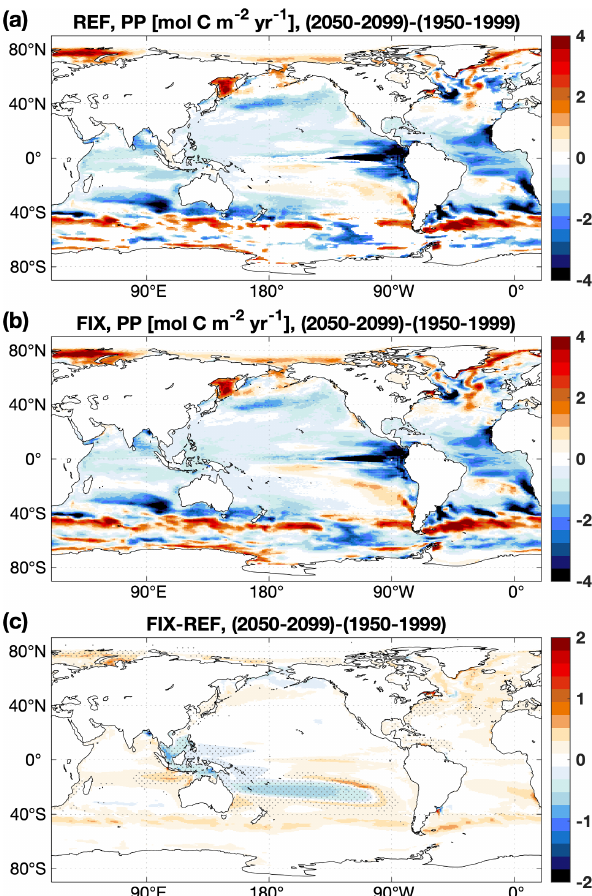
Figure 6. The difference in vertically integrated primary production between 2050–2099 and 1950–1999 time periods in (a) REF, (b) FIX, and (c) the difference between (b) and (a) . In panel (c) , only significant differences are plotted, and dots denote areas where the signal is larger than the standard deviation of the absolute field (see details in Appendix